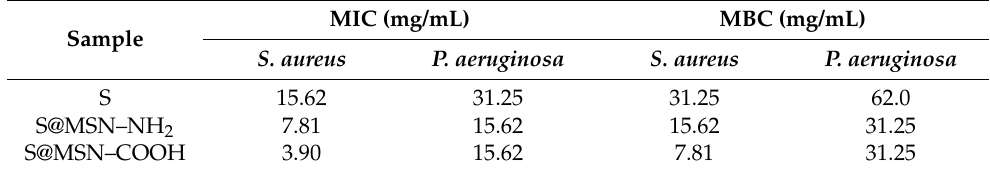
Table 2. Antibacterial activity of free common sage extract and embedded in functionalized MSN.